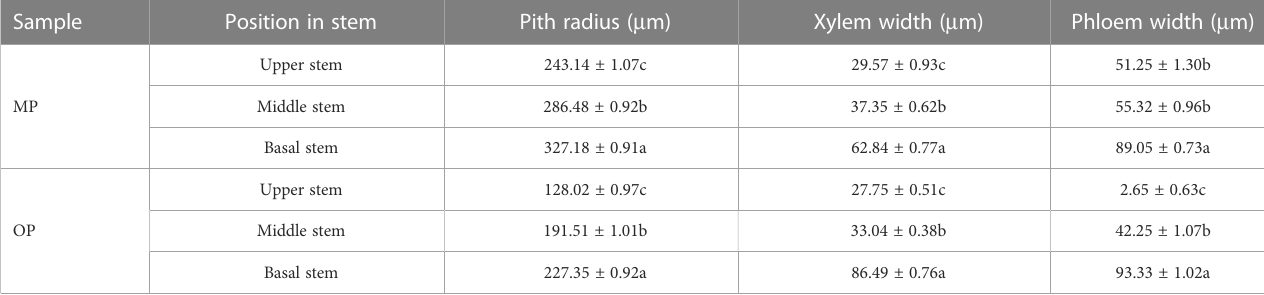
TABLE 3 Anatomical characters of the stem in transverse section for the mutant (MP) and wild type (OP).